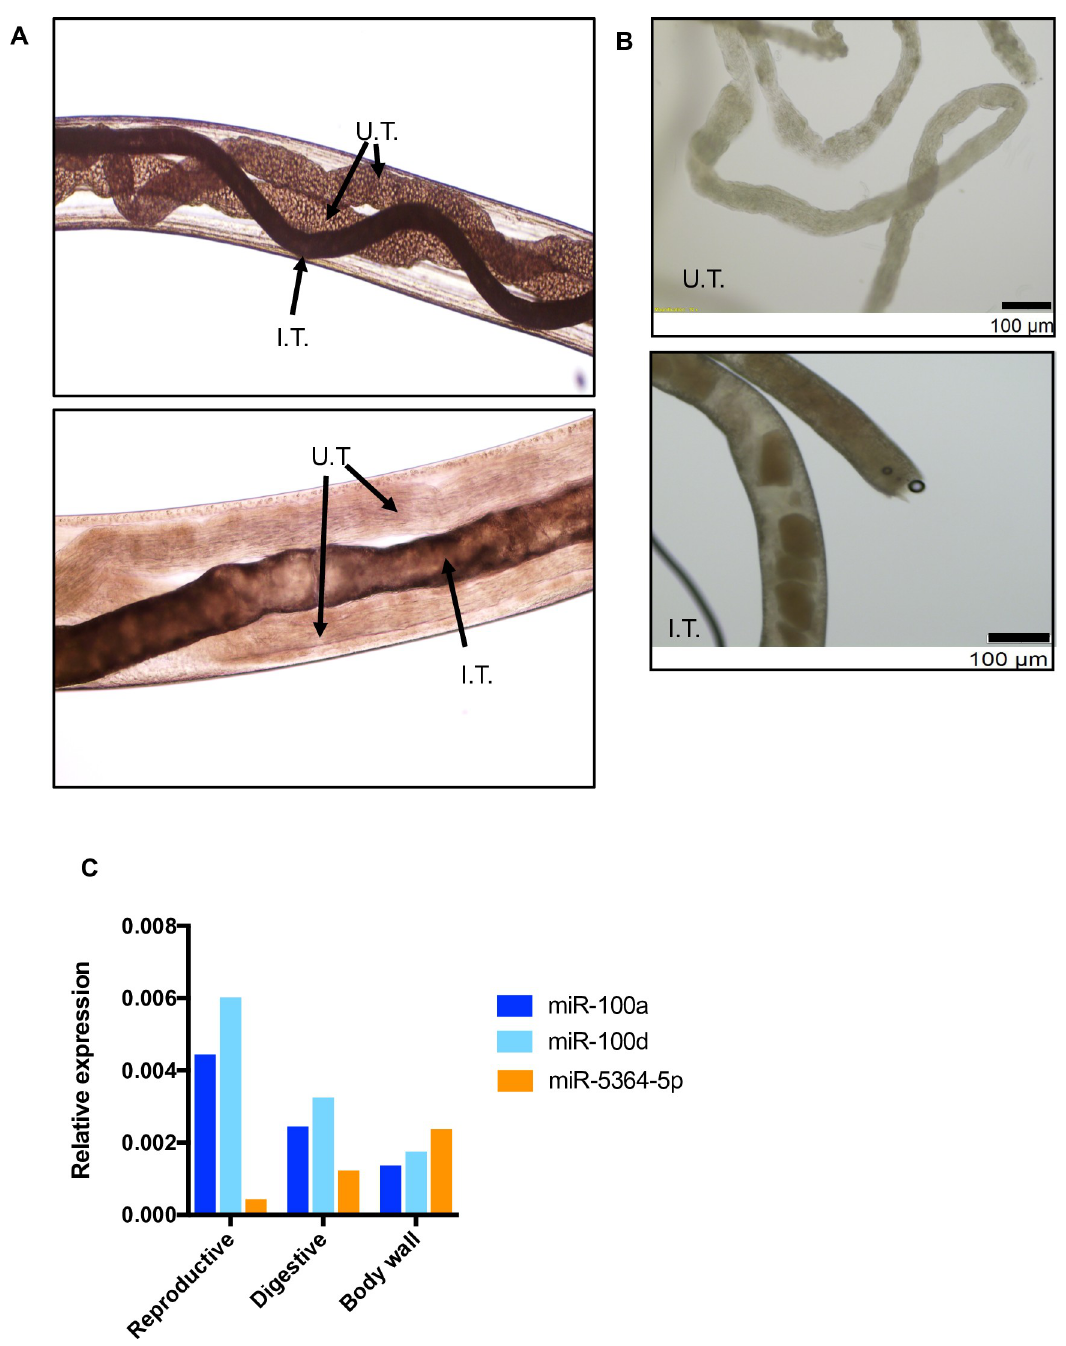
Fig 5. Tissue detection of miRNAs in gravid adult female worms. Adult female worms were dissected and tissues recovered as described in the materials and methods section. Micrographs in ( A ) show a middle body section (upper panel) and anterior section (lower panel), where both uteri (U.T) and the intestinal tube (I.T.) are indicated with arrows, and are anatomically consistent with previously published structures for filarial gravid adult female worms [58,59]. B ) After dissection, the reproductive tissue (upper panel) and digestive tissue (lower panel) were harvested together with the cuticle. C) qRT-PCR of miRNAs shown to be enriched in the ES of gAFs, normalized to the signal of 18S rRNA. The qRT-PCR results described here correspond to a single pooled samples from 60 individual female